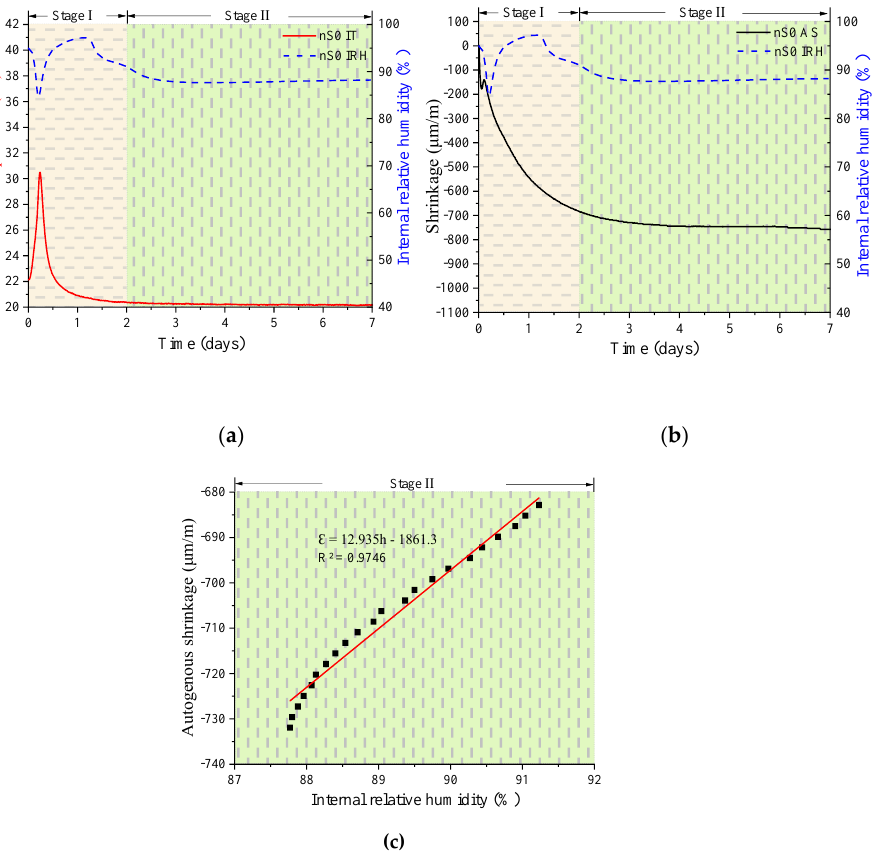
Figure 5. Development of the internal relative humidity (IRH) and internal temperature (IT) ( a ) and autogenous shrinkage ( b ) with the age of the nS0 specimen. Linear regression results ( c ) of the IRH and autogenous shrinkage of the nS0 specimen in stage II.